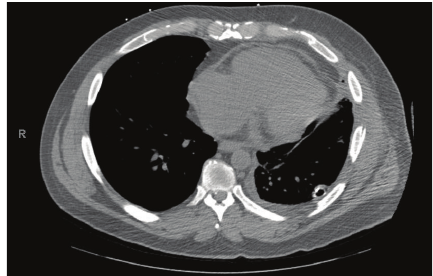
Figure 2: The CT study performed on postoperative day 7 that shows dramatic improvement in the cardiac position as well as decreased atelectasis of the lower lobe of the left lung.